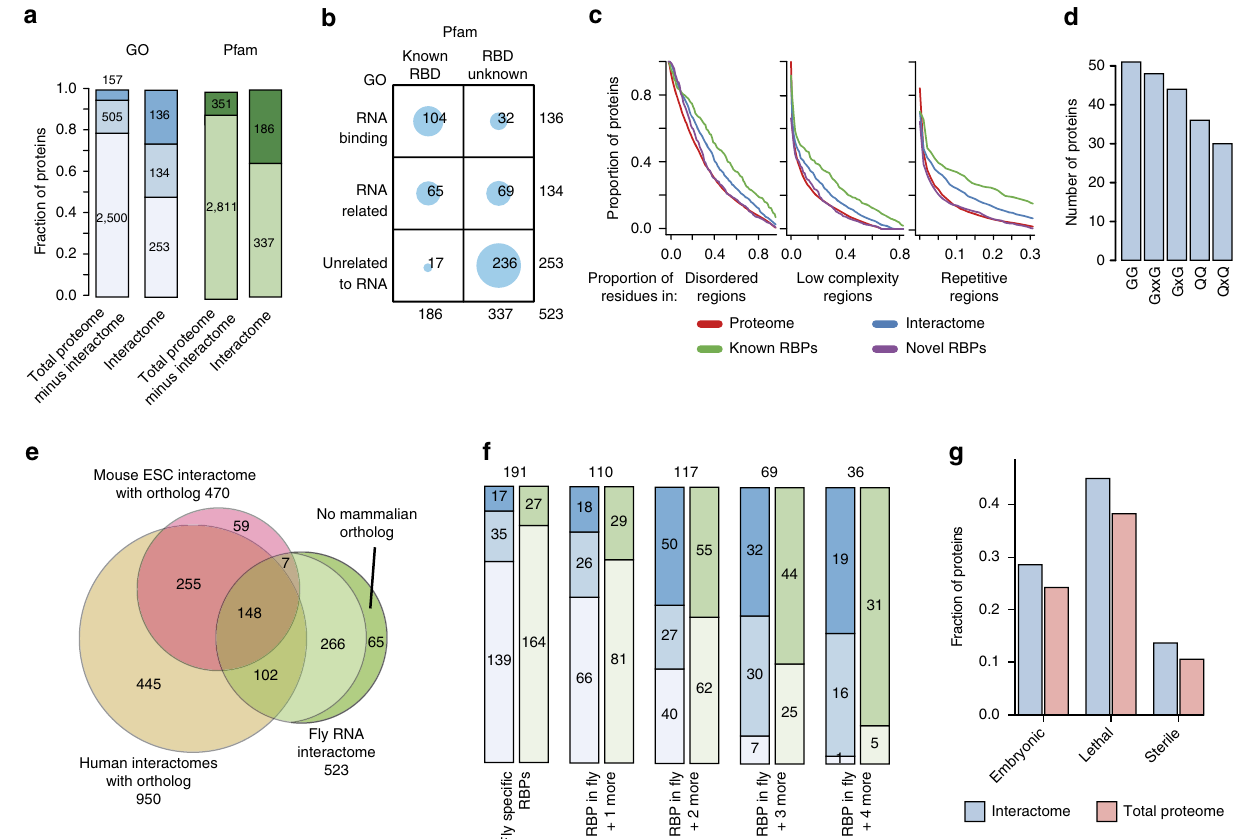
Figure 2 | Composition of the Drosophila mRNA interactome and its links to development. ( a ) Blue bars: numbers of proteins annotated with GO term ‘RNA binding’ and other RNA-related GO terms. Green bars: numbers of proteins containing and not containing domains annotated as RNA-binding in the Pfam database. Dark blue: GO term ‘RNA binding’; medium blue: RNA-related GO terms; light blue: GO annotation unrelated to RNA; dark green: known RBD; light green: no known RBD. ( b ) Balloon plot related to a . ( c ) Distribution of disordered regions, low complexity domains and repetitive sequences in the total proteome (red), RNA interactome (blue), previously known RBPs (green) and newly discovered RBPs (purple) in the RNA interactome. Two-sample Kolmogorov–Smirnov test P values are listed in the Supplementary Note 3. ( d ) Five most frequent repetitive sequence patterns in the RNA interactome. ( e ) Venn diagram showing numbers of proteins belonging to the human (yellow), mouse (pink) and fly (green) interactomes. Of 266 fly-specific RBPs 65 do not have a mammalian ortholog. ( f ) Blue bars: fly-specific RBPs and RBPs shared with one or more eukaryotic interactomes are compared to RNA-related GO terms (blue bars). Green bars: numbers of proteins with Pfam-annotated known RBDs. ( g ) Fractions of proteins with embryonic, lethal and sterile phenotypes in the RNA interactome (blue) and the proteome (red). Fischer test P values resulting from comparison of the interactome to the proteome: lethal—0.00346; embryonic—0.03483;